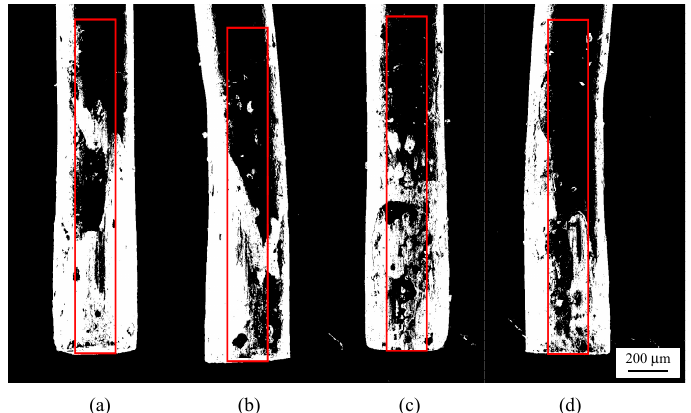
Figure 9. Binary image of copper wire (SC-2-1) surface and the evaluation area (red rectangle): ( a ) 0 degrees; ( b ) 90 degrees; ( c ) 180 degrees; ( d ) 270 degrees.